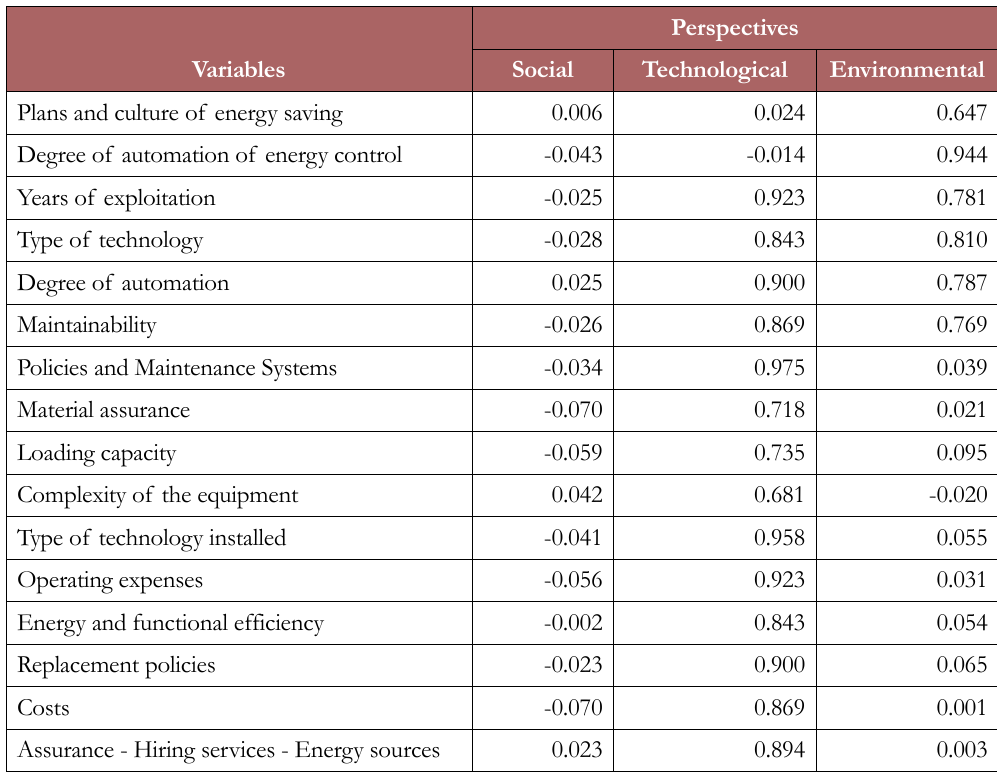
Table 1. Results of the correlation between the variables and the axes of the factorial analysis of correspondences for the TS